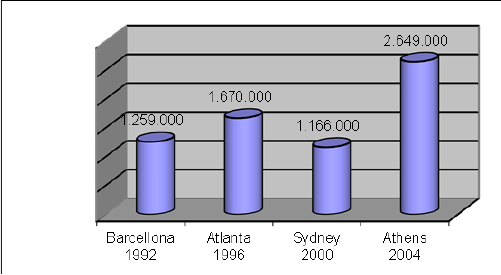
Figure 15: Average TV Audience for Athens Olympics in Italy